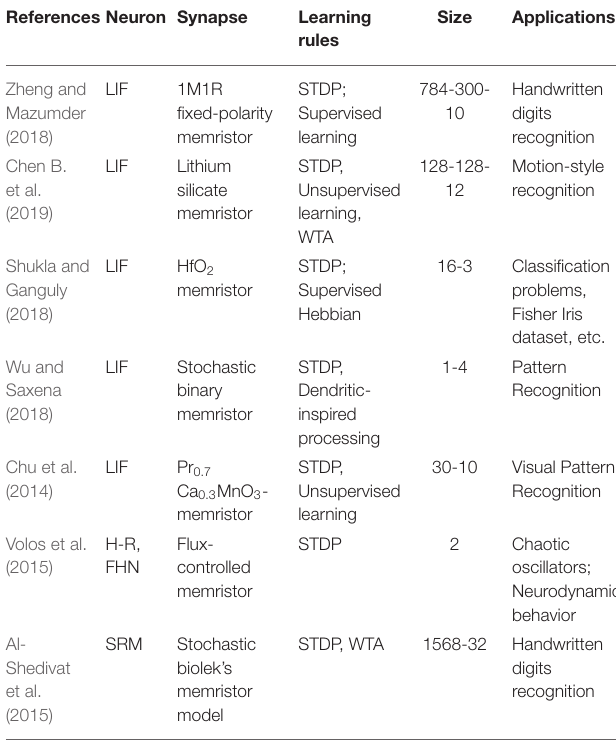
TABLE 5 | Comparison of several memristor-based